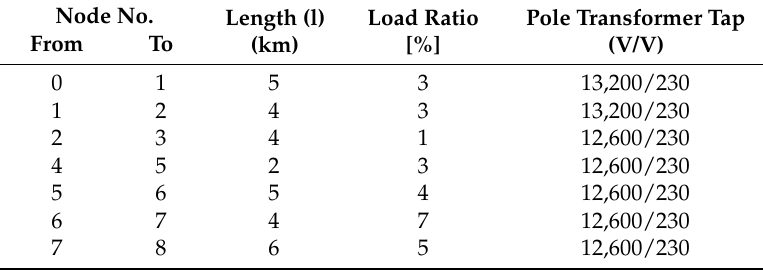
Table 1. High-voltage distribution line section data for Feeder 1.